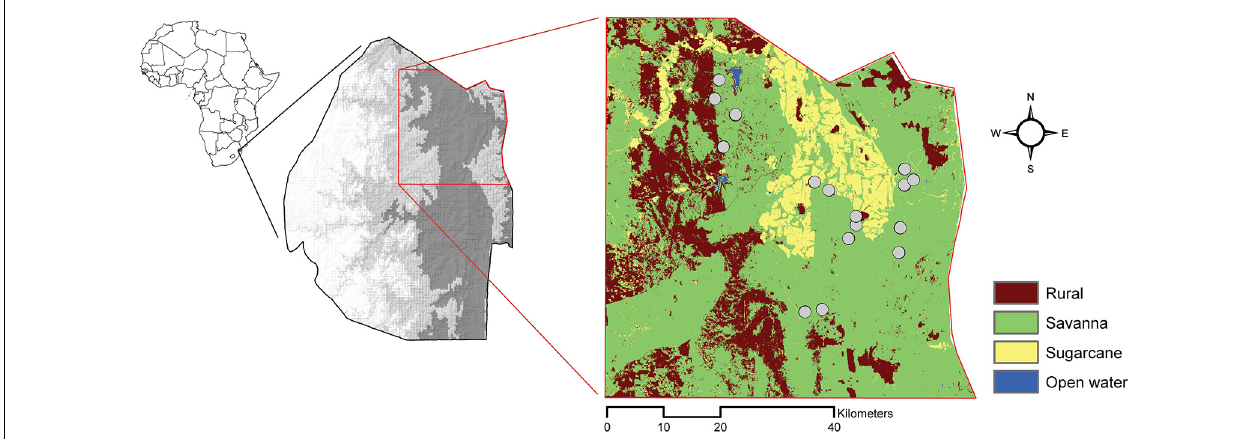
FIGURE 1 | Map detailing the country of Eswatini (gray scale depicts elevation; darker gray is lower elevation) and our study area. Our study area is delineated in red, and our sampling sites (gray circles) are overlayed on our classification of land-cover